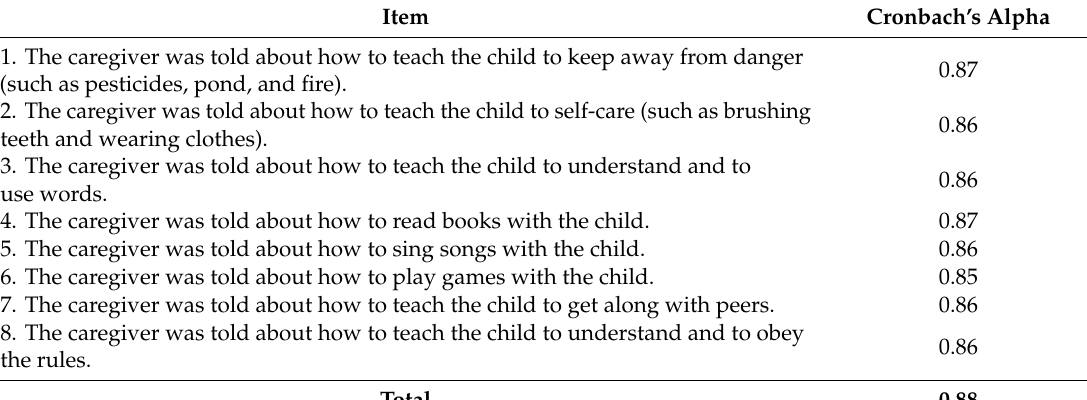
Table A1. Parenting information questionnaire.